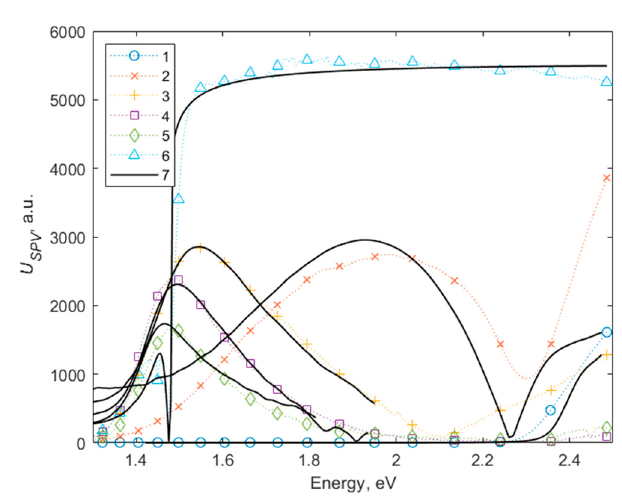
Figure 7. Experimental and theoretical SPV spectra of CdS 1 − x Te x samples, excitation from the top side. Solid lines are theoretical fittings. Table 2. Collected data of diffusion lengths of carriers for CdS 1 − x Te x